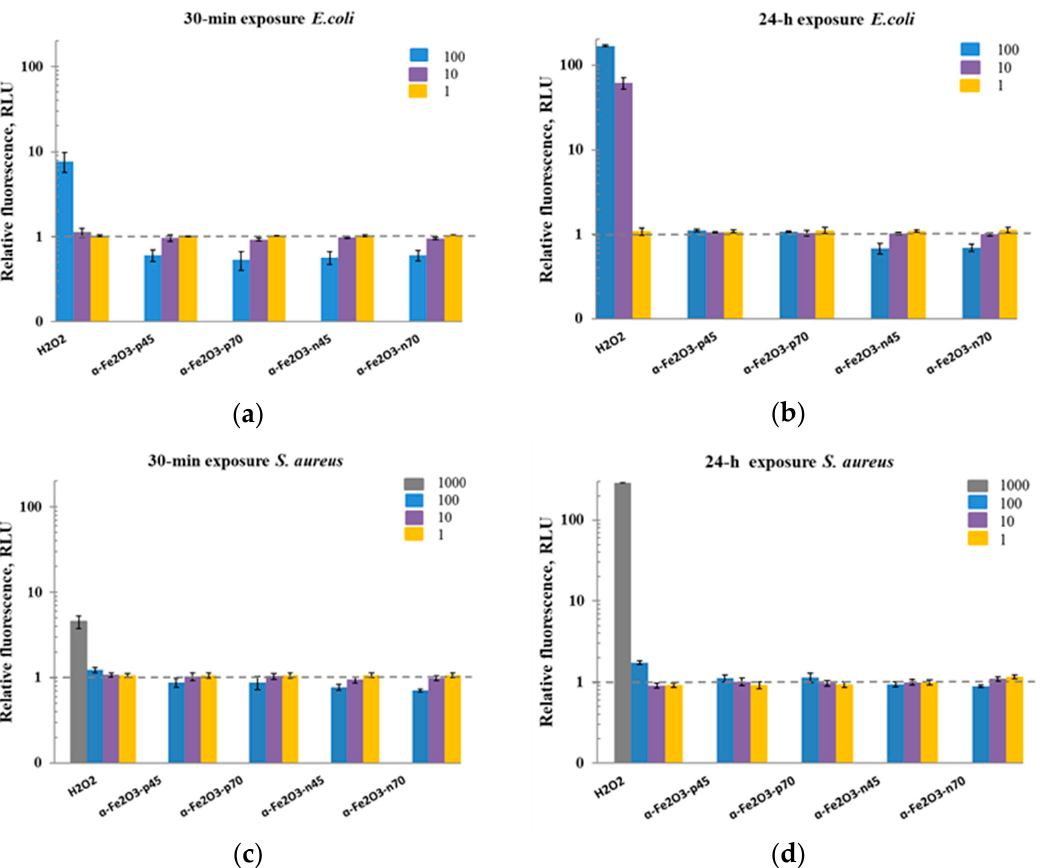
Figure 10. Generation of ROS measured with fluorescent dye DCF-DA in the biotic conditions after 30 min ( a – c ) and 24 h ( b – d ) exposure to hematite NPs (1–100 mg/L), and H 2 O 2 as a positive control (1–100 mg/L for Escherichia coli ; 1–1000 mg/L for Staphylococcus aureus ) in DI water. The values are presented as fold-increase in fluorescence of exposed cells compared to unexposed cells; the mean of 3 experiments is given ± SD. All exposure concentrations are nominal. The dashed horizontal line highlights the ROS level in the control bacteria in DI water. Graphs of ROS generation in biotic conditions after 24 h of NP incubation with bacteria and 30 min after dye adding points can be found in the Supplementary Material (Figure S3).